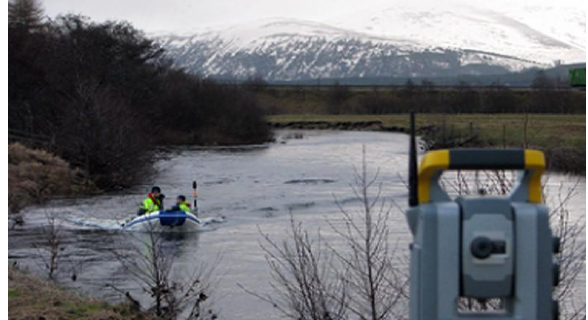
Figure 4. Example of a normal riverbed survey for small rivers ( CainTech, 2014 ).